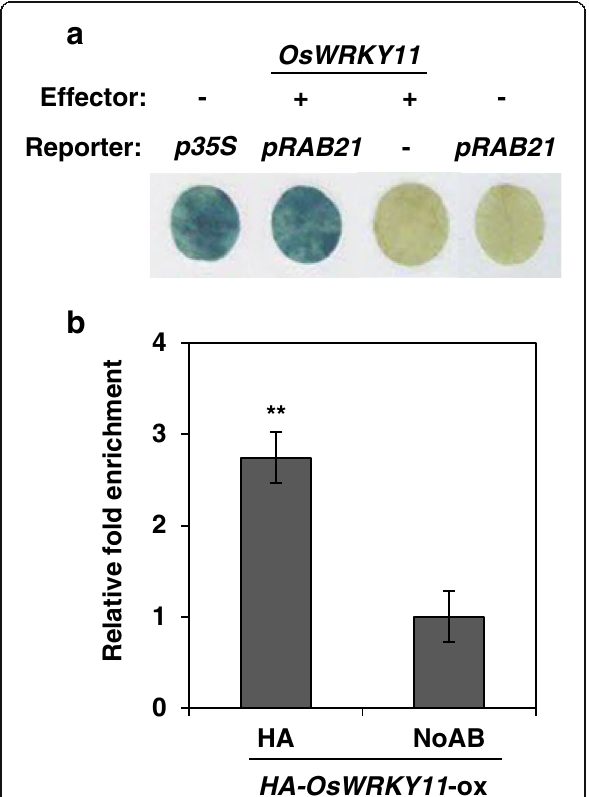
Fig. 6 Os WRKY11 directly binds to and activates the RAB21 promoter. a Nicotiana benthamiana leaf discs were infiltrated with Agrobacterium carrying pRAB21::GFP-GUS alone or with a mixture of Agrobacterium carrying 35S::OsWRKY11 and pRAB21::GFP-GUS . Promoter activity in each sample was visualized 2 days post-infiltration using β -glucuronidase (GUS) activity staining. b Transgenic rice leaves expressing 35S :: HA - OsWRKY11 were used for chromatin immunoprecipitation with anti-HA antibody. ChIP-PCRs were performed on genomic DNA fragments using promoter-specific primers against RAB21 (Table S1). To normalize qPCR values, the value obtained from the sample with pre-immune serum (no antibody) was divided by the value obtained from the sample with 10% input of each sheared chromatin sample and arbitrarily set at 1. The value obtained from Os WRKY11 binding to the promoter was expressed as a relative ratio of the pre-immune serum sample. Asterisks indicate significant differences between treatments from the no-antibody control sample (**: P <0.01; *: P